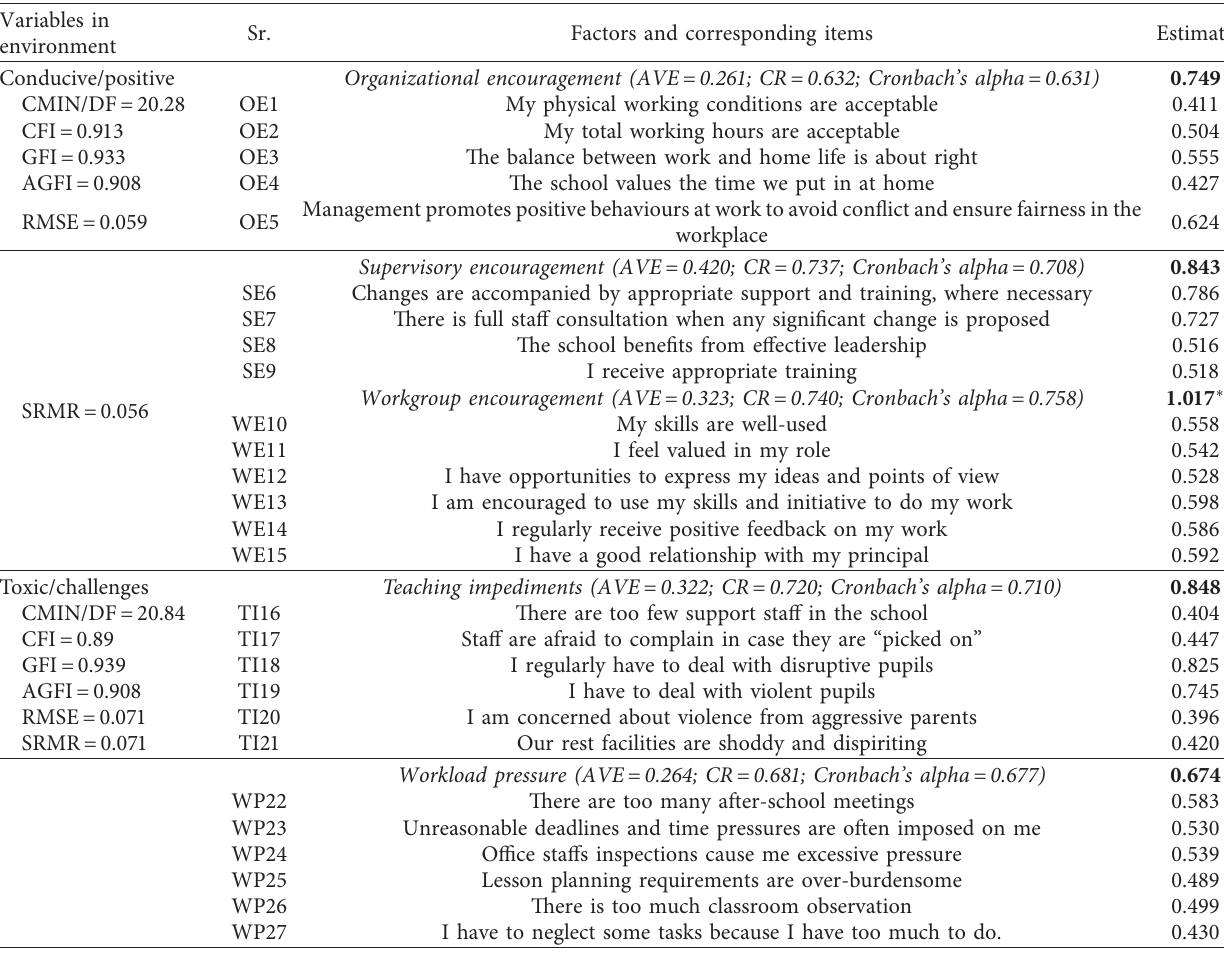
Table 2: Estimated standardized regression weights of conducive and toxic variables in distinct